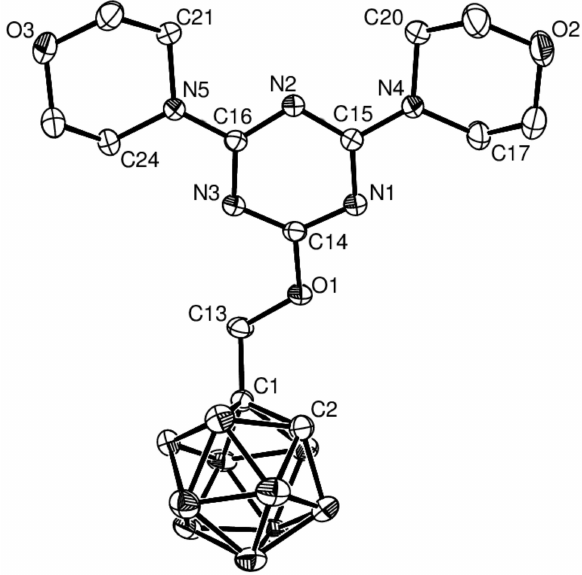
Figure 1. Molecular structure of 5 with thermal ellipsoids drawn at the 30% level. Hydrogen atoms are omitted for